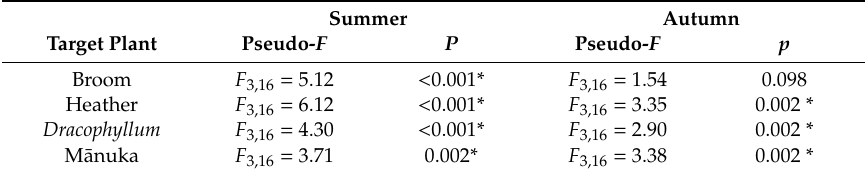
Table 7. Permutational analysis of variance (PERMANOVA) results for di ff erences in arthropod community composition on target plants at sites where they either occur with conspecifics or one of the three heterospecific plants ( n = 5 for each treatment).